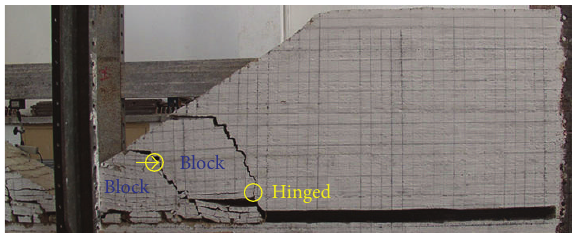
Figure 6: The overburden movement in response to underground mining in upslope direction.